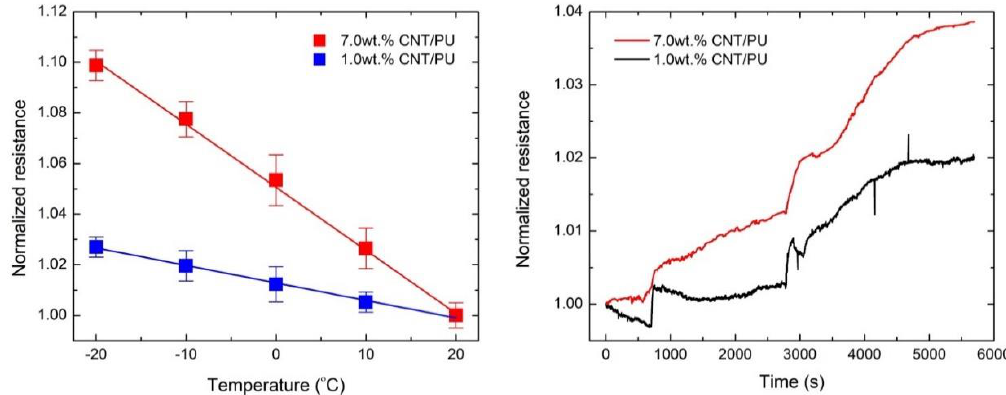
Figure 4. Freezing temperature sensing of the CNT/PU coatings: Normalized resistance vs. Temperature (left) and Normalized resistance vs. Time (right).